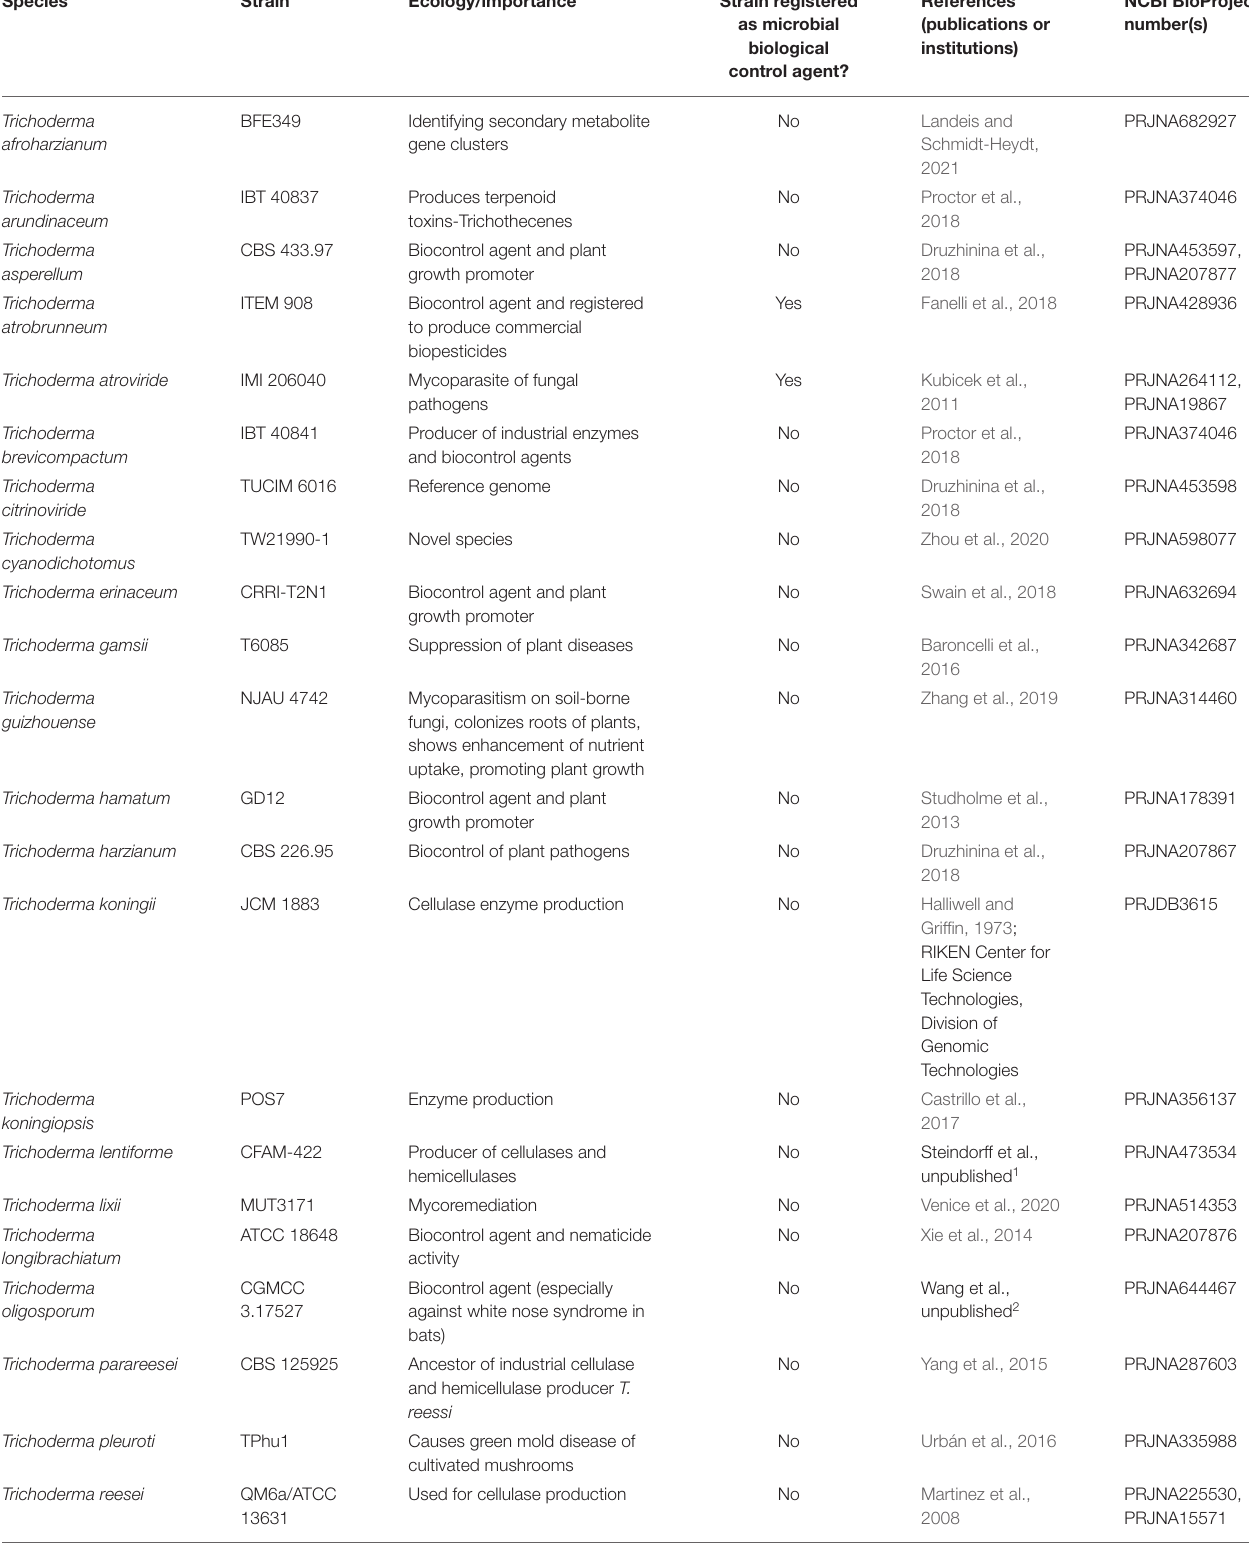
TABLE 1 | List of Trichoderma species examined in this